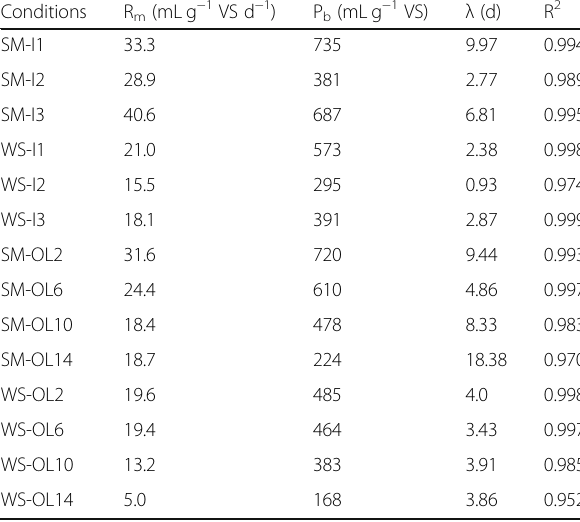
Table 2 Kinetics parameters of modified Gompertz model for various inoculum type and OL